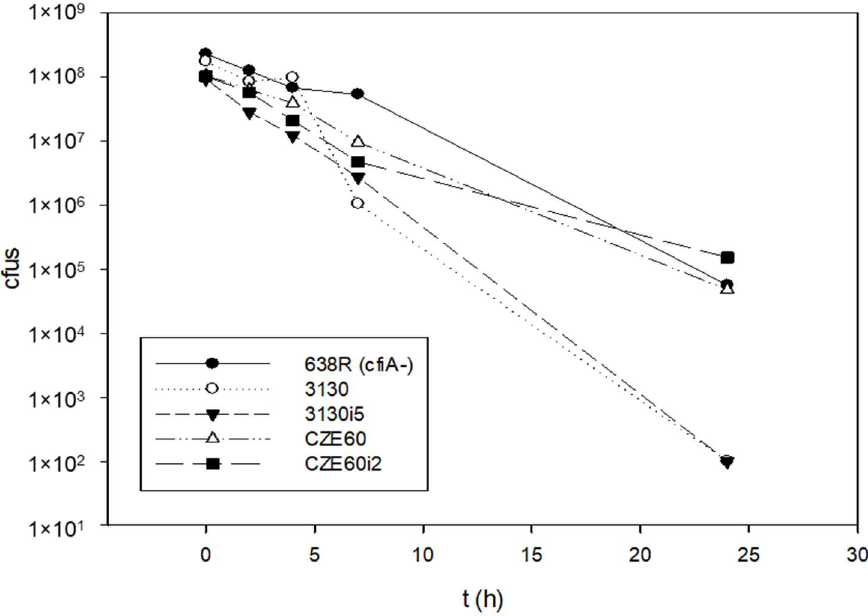
Figure 6. Time–kill curves of B. fragilis strains with or without cfiA gene. B. fragilis 638R was cfiA - negative, all the other strains were cfiA -positive. The imipenem non-induced and induced variants pf B. fragilis 3130 and CZE60 did not show much difference in their killing curves.